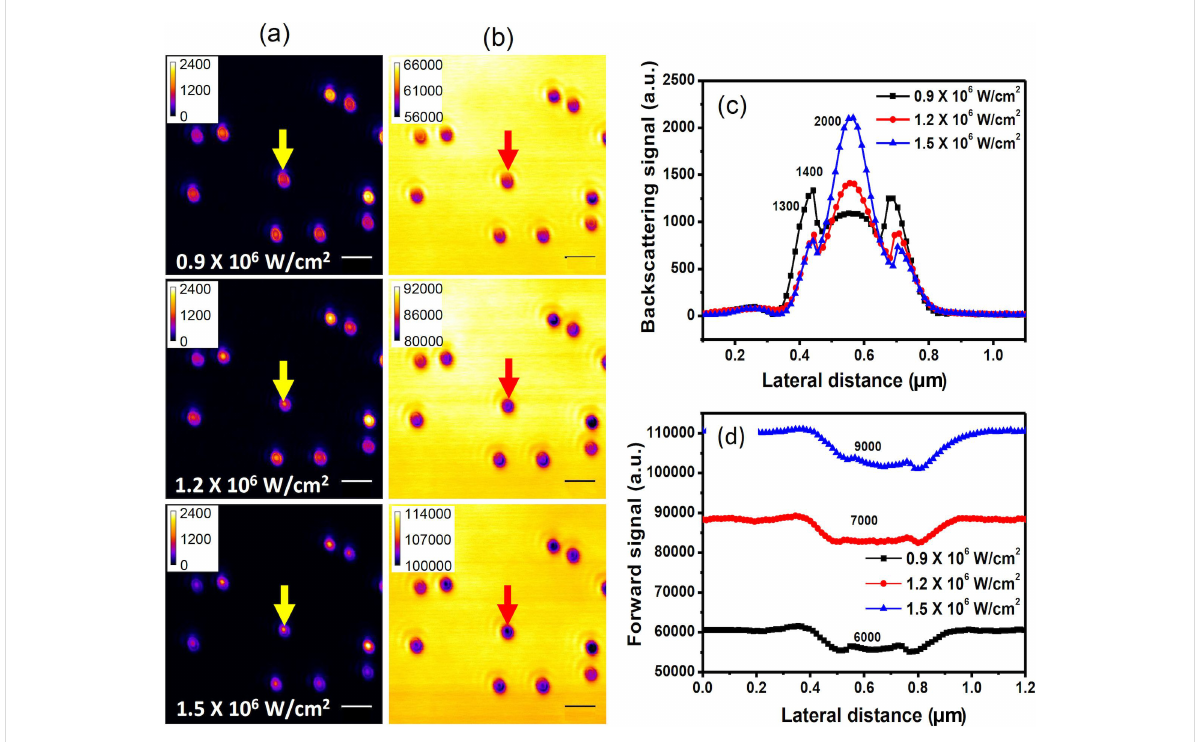
Figure 4: (a) Backward path and (b) forward path images of the same ten spherical gold nanostructures as in Figure 3 at excitation intensities above 10 6 W·cm − 2 . The x -scan signal profiles of the spherical gold nanostructure marked by arrows in (a) and (b) are given in (c) and (d), showing strong nonlinear responses of the backscattering and the attenuation signals versus the excitation intensity. The number on each peak represents the signal quantity at the center of the PSF (positive for backscattering and negative for attenuation). The scale bar is 1 µm.